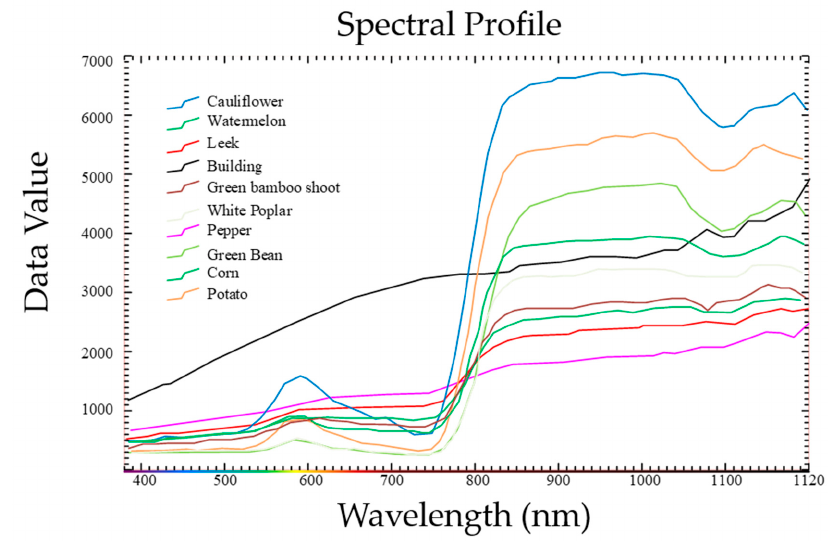
Figure 3. Average spectral curves for di ff erent land cover types in the data collection